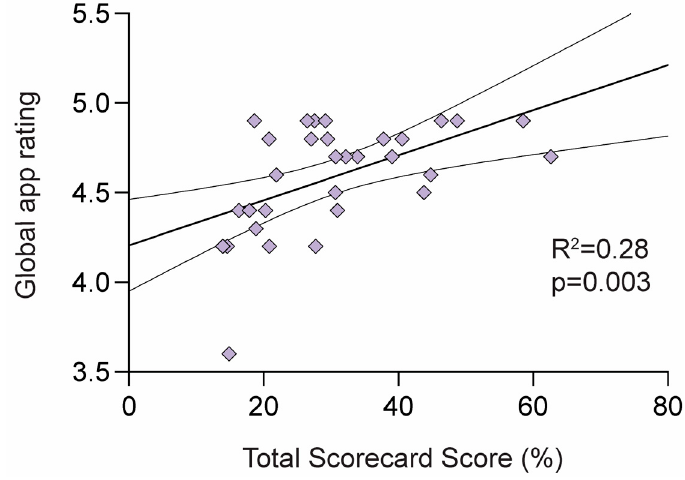
Figure 5. Linear regression between total scorecard score and the global app ratings for all 31